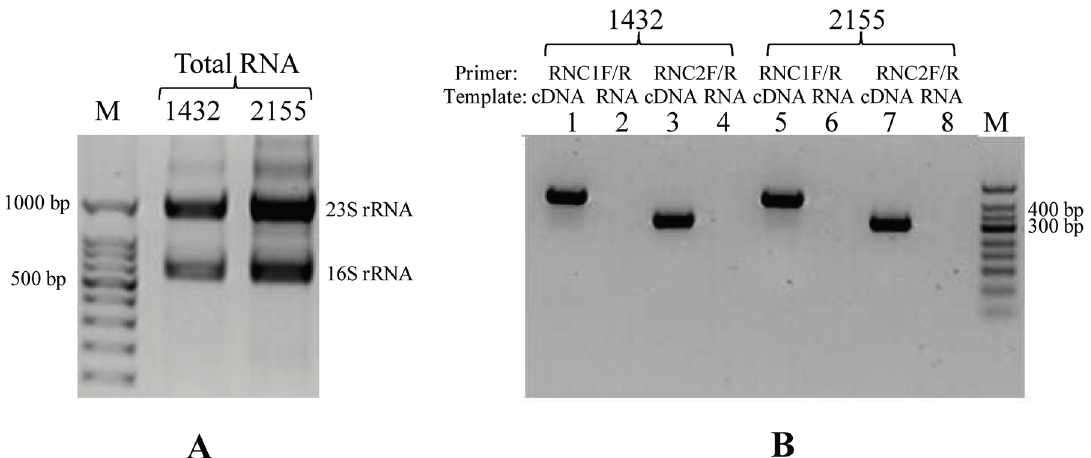
Figure 4. Electrophoretic results of total RNA and reverse transcriptional-PCR. ( A ) Total RNA extracted from A. ucrainica CHAB1432 and CHAB 2155 (2% agarose; the two bands, 23S and 16S rRNA, indicate a high quality of extracted total RNA); ( B ) Lanes 1,